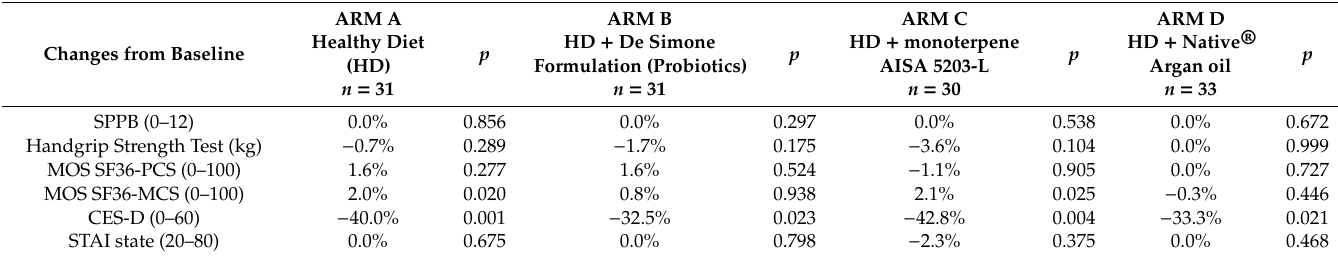
Table 3. Percentage of median change from baseline in physical, depression and anxiety tests for each dietary